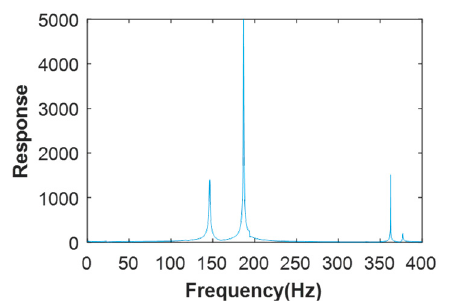
Figure 22. Acceleration response with respect to time.